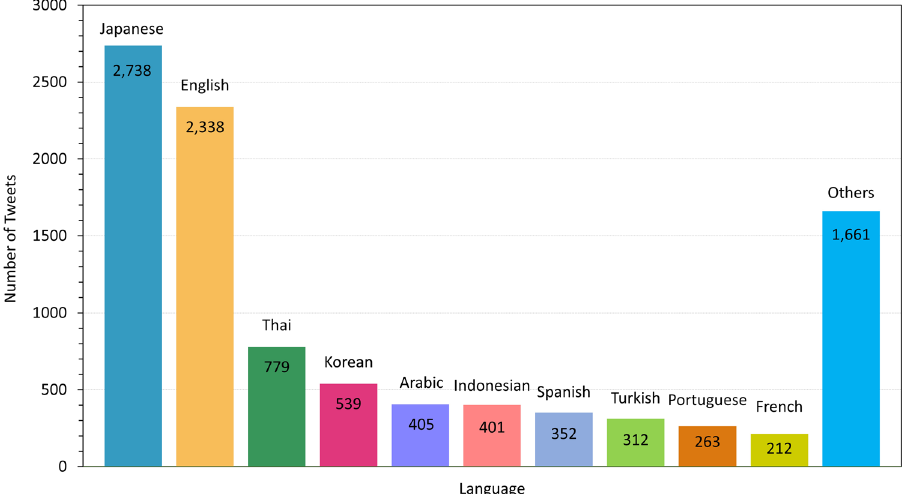
Fig. 2 The main language distribution of 10,000 randomly collected users on